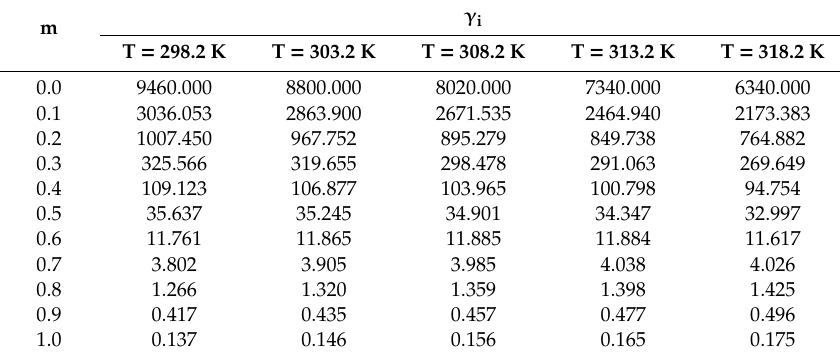
Table 2. The estimated values of γ i for PPD in binary DMSO + water mixtures ( m ) at T = 298.2 K to 318.2